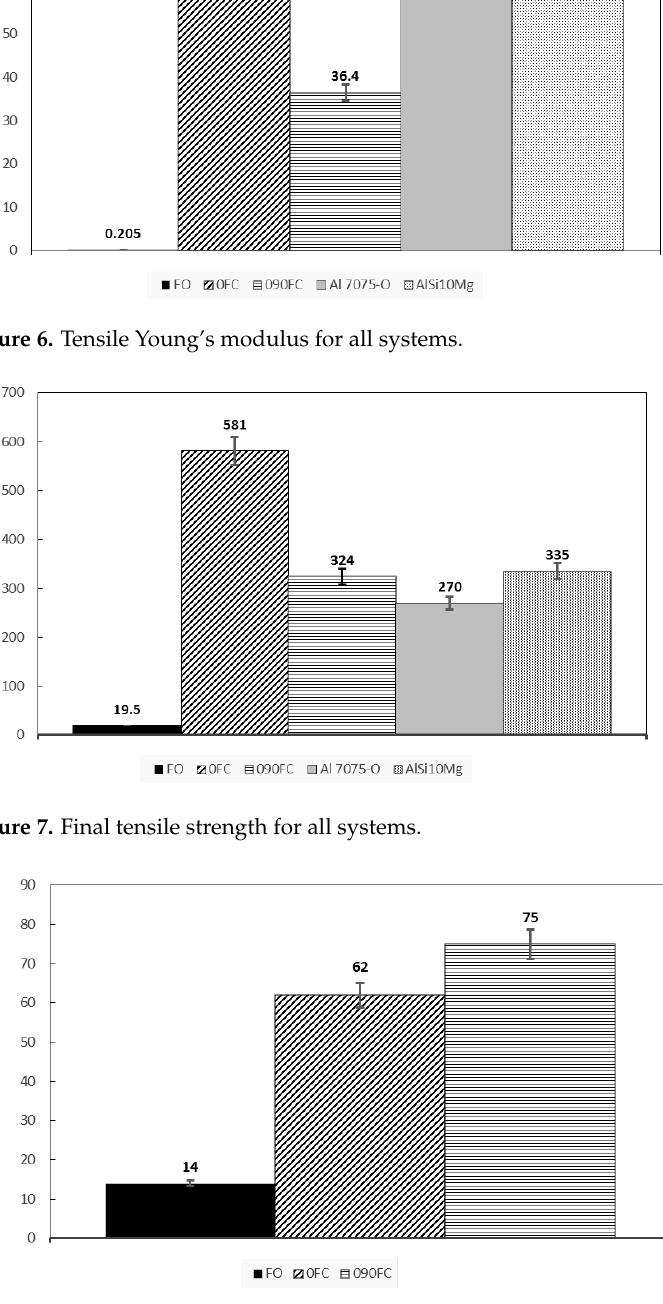
Figure 8. Final compression strength for all systems.